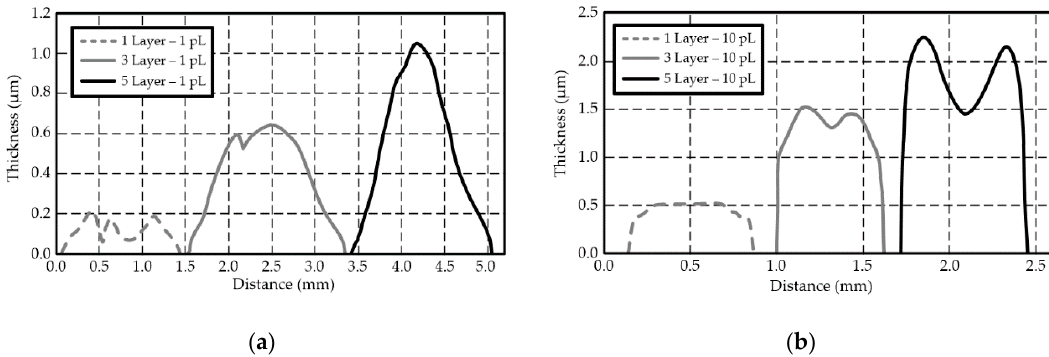
Figure 3. An inkjet-printed silver nano-particle-based metal trace as a function of the number of printed layers and the ink droplet volume: ( a ) 1 pL (width: 1.0 mm), and ( b ) 10 pL (width: 0.5 mm).